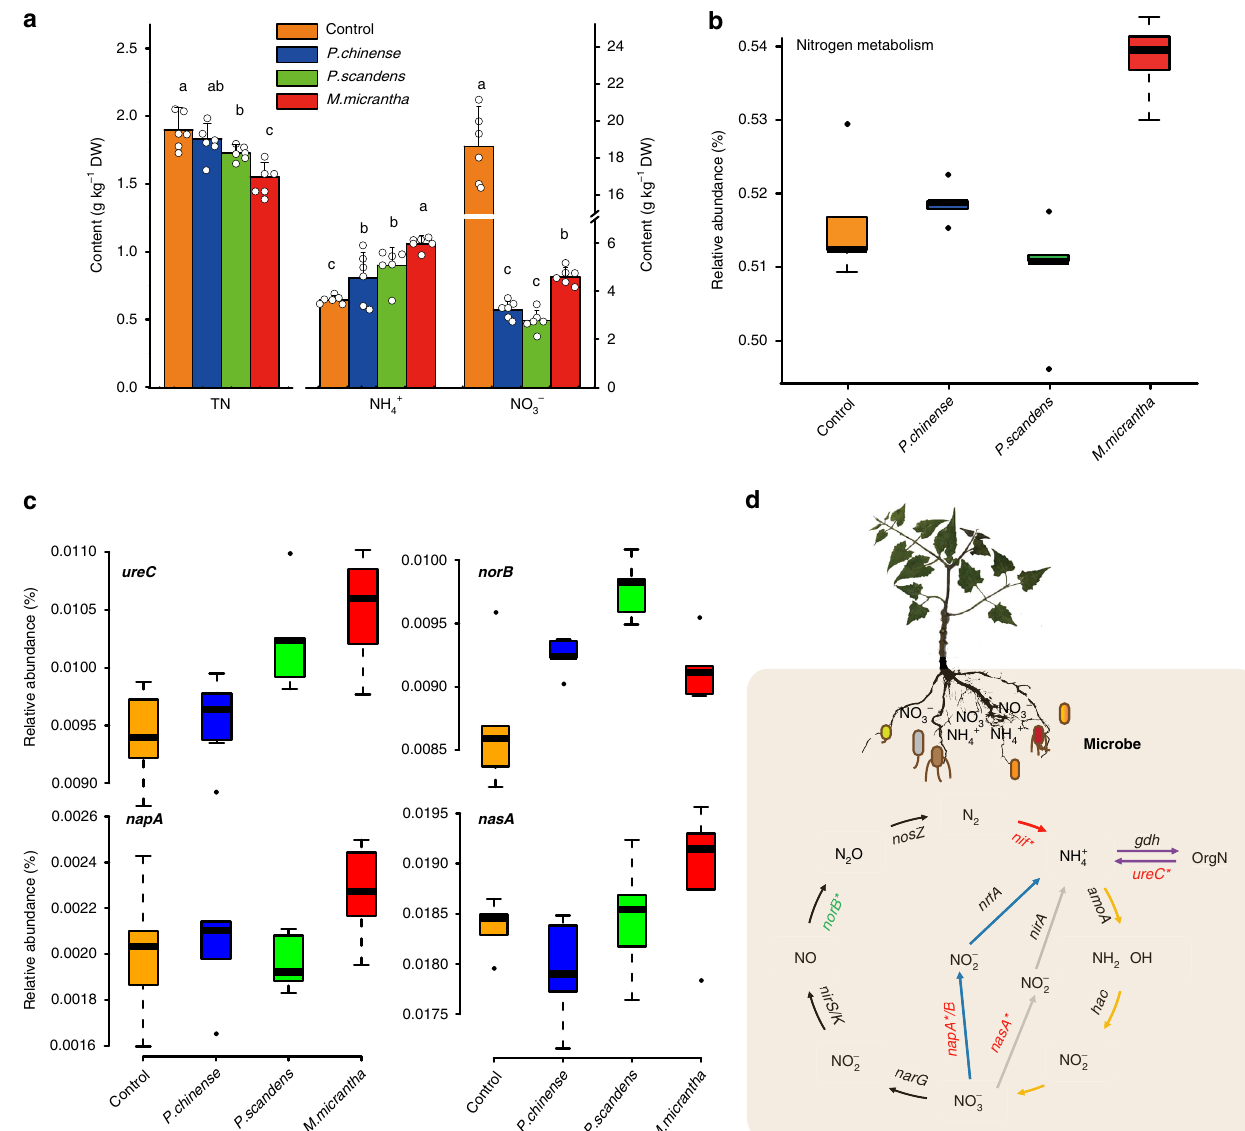
Fig. 6 Effect of Mikania micrantha metabolites on soil nitrogen cycling. STLs: sesquiterpene lactones. a Soil nitrogen content in the pot experiment of M. micrantha and its two neighboring native species. n = 6 biologically independent soil samples. We used Duncan ’ s multiple range test ( p < 0.05) method. Data with different letters in the same column are signi fi cantly different. Control indicates that no plants were planted. Error bars indicate average value ± s. d. of indicated replicates. b Box plots of the relative abundance of genes involved in nitrogen metabolism pathway. Adjusted p value was calculated using Dunn ’ s test. n = 5 biologically independent soil samples. c The relative abundance of key genes of soil microorganisms involved in assimilatory nitrogen reduction ( nasA ), dissimilatory nitrogen reduction ( napA ), ammoni fi cation ( ureC ), and denitri fi cation ( norB ) between M. micrantha and its two neighboring species ( Polygonum chinense and Paederia scandens ) as well as in the blank control. Adjusted p value was calculated using Dunn ’ s test. n = 5 biologically independent soil samples. On each box plot, the central mark indicates the median, the bottom and top edges of the box indicate the interquartile range (IQR) and the whiskers represent the maximum and minimum data points. d A schematic of nitrogen cycling in the M. micrantha soil. Red and green indicate that the abundance of the gene in M. micrantha soil was upregulated and downregulated compared to that in the soil of the two neighboring species ( P. chinense and P. scandens ), respectively. Black, orange, red, blue, gray, and purple arrows indicate the denitri fi cation, nitri fi cation, nitrogen fi xation, dissimilatory nitrogen reduction, assimilatory nitrogen reduction, and ammoni fi cation, respectively. The source data underlying Fig. 6a – c are provided as a Source Data fi